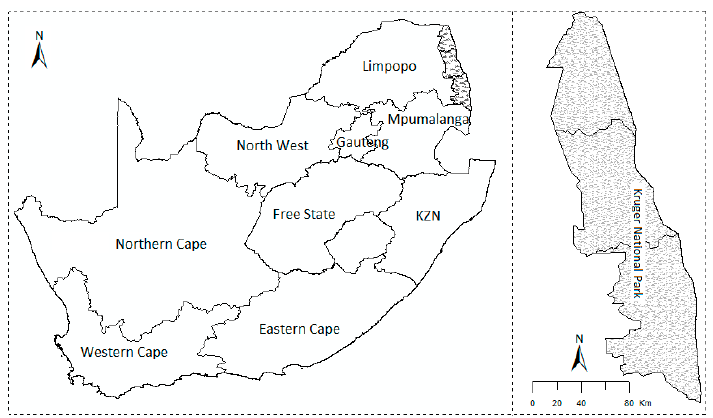
Figure 1. Location of the study area.